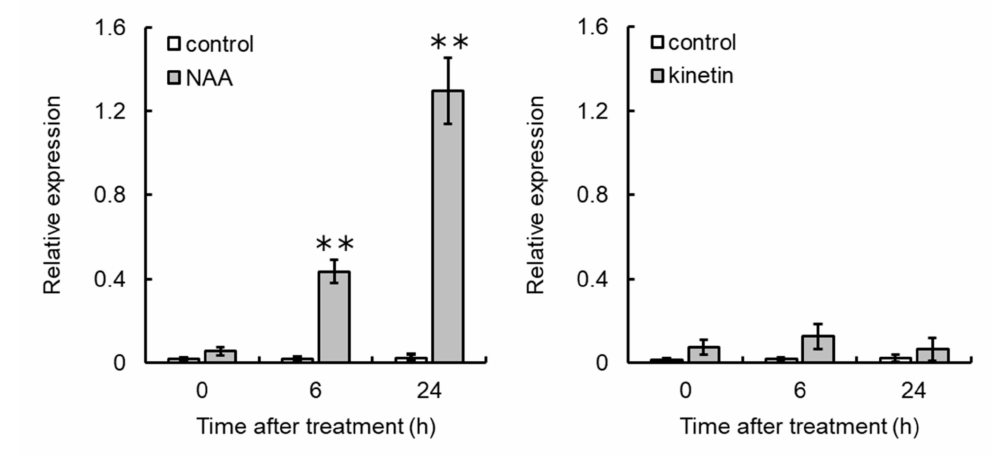
Figure 5. Exogenous NAA upregulated VvCKX5 gene expression in VR cells. VR cells were treated with excess amounts of NAA or kinetin. Total RNA was isolated from VR cells and subjected to real-time RT-PCR. Actin was used as an internal control. Data were calculated as gene expression level relative to actin gene expression level. Bars indicate means ± standard deviations of five independent experiments. ** p < 0.01 compared with control (Student’s t